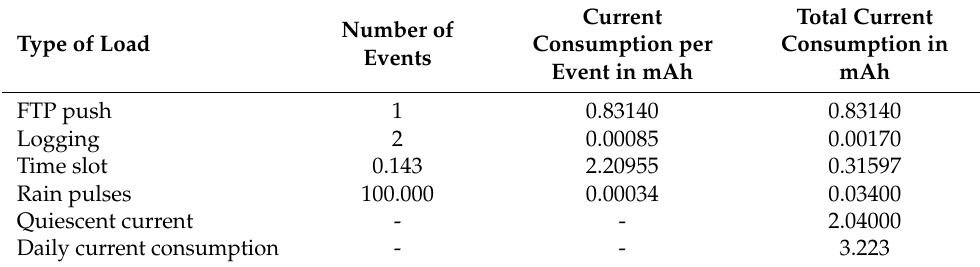
Table 3. Daily current consumption of the UniLogCom with RG50 sensor with a 12 V supply.